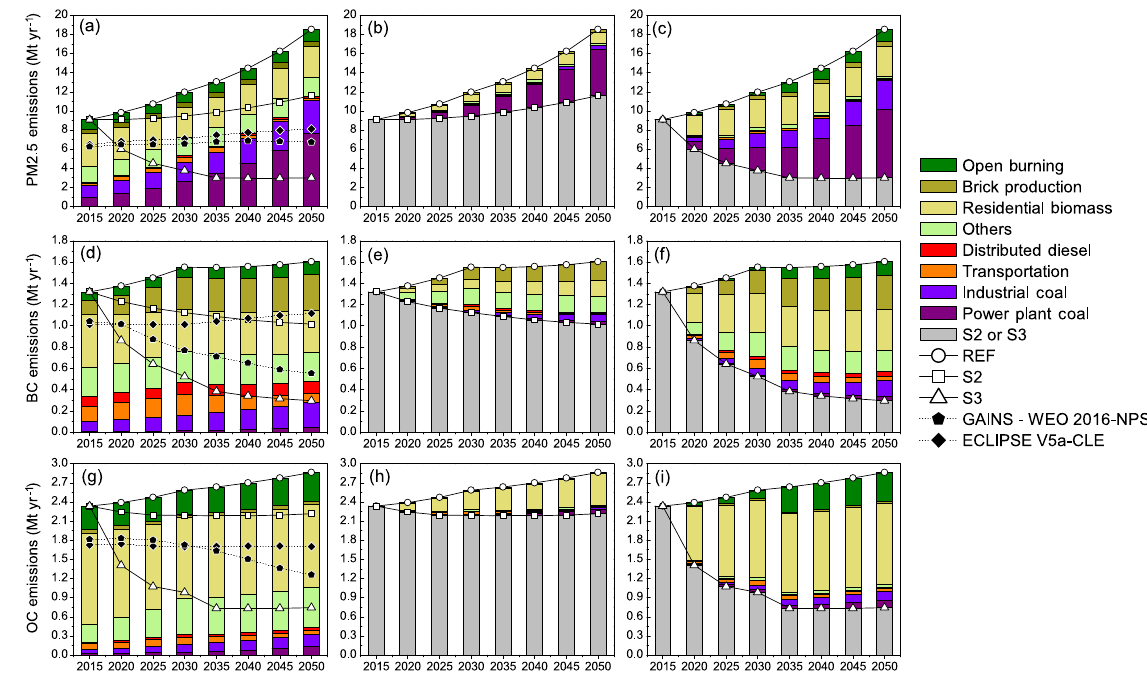
Figure 2. Sectoral emission of fine (a) particulate matter, (d) black carbon and (g) organic carbon under the three scenarios, for 2015–2030 (column 1). Differences of higher efficiency/emission control scenarios from reference (S2 & S3) are shown in column 2 (b, e, h) and column 3 (c, f, i) . Emissions from ECLIPSE V5a-CLE and GAINS-WEO2016-NPS are shown for comparison.